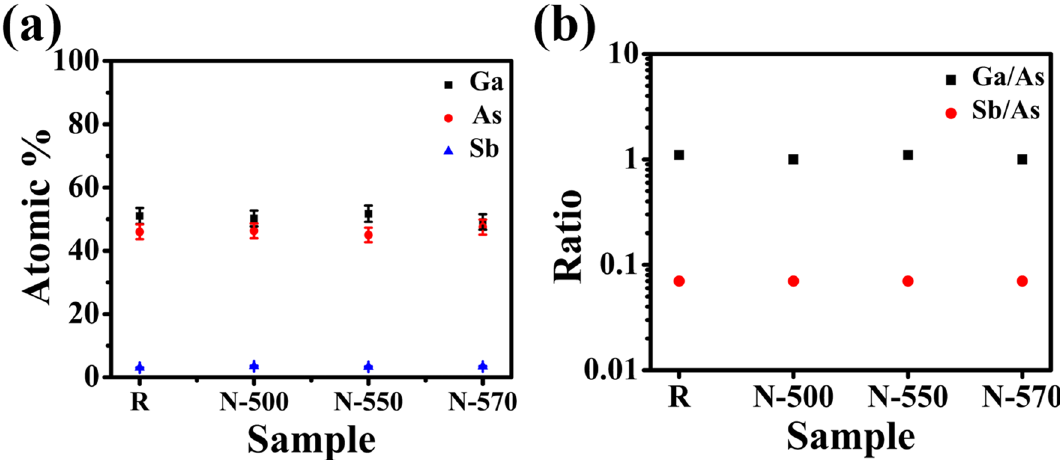
Figure 2. ( a ) Atomic % of Ga, As, and Sb in R, N-500, N-550, and N-570 samples and ( b ) ratio of Ga/As and Sb/As in R, N-500, N-550, and N-570